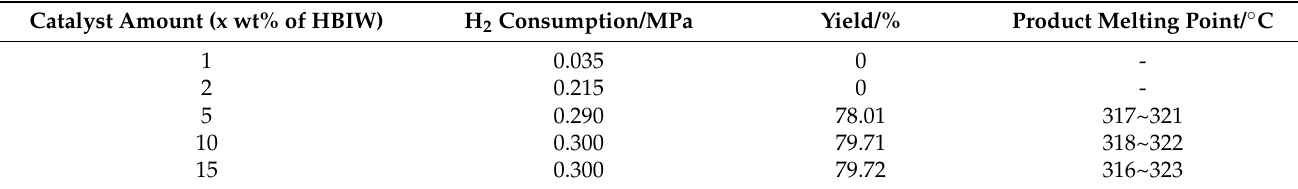
Table 2. Effect of 5 wt.% Pd/C catalyst dosage on TADBIW